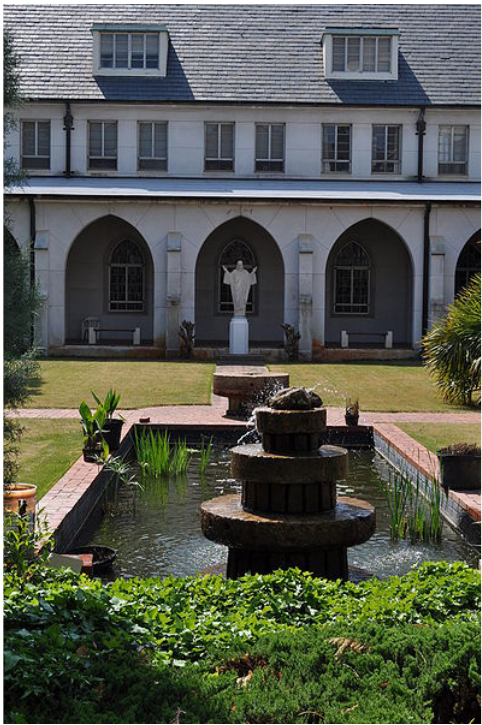
Figure 8. Cloister garden at Holy Spirit Monastery (photo from Wikimedia Commons,